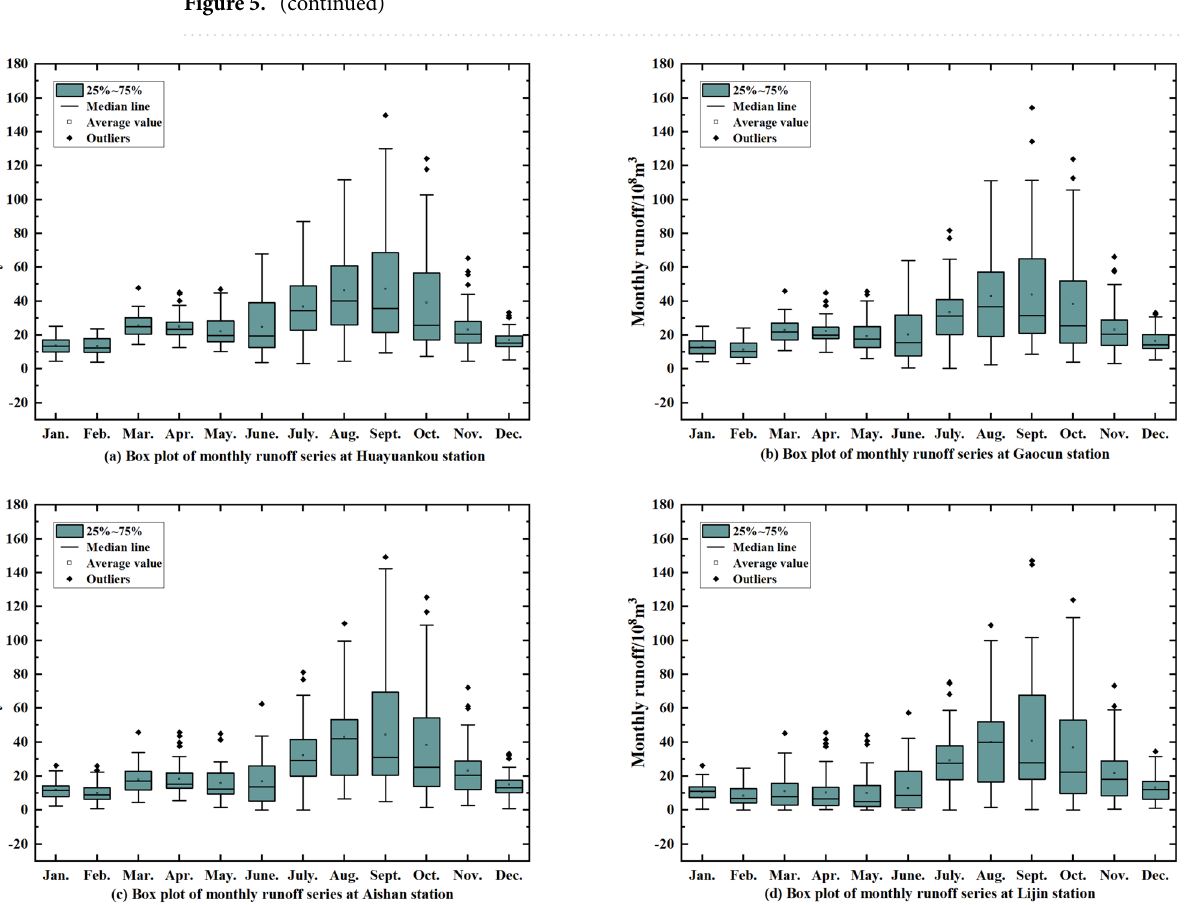
Figure 6. Yellow River downstream runoff box